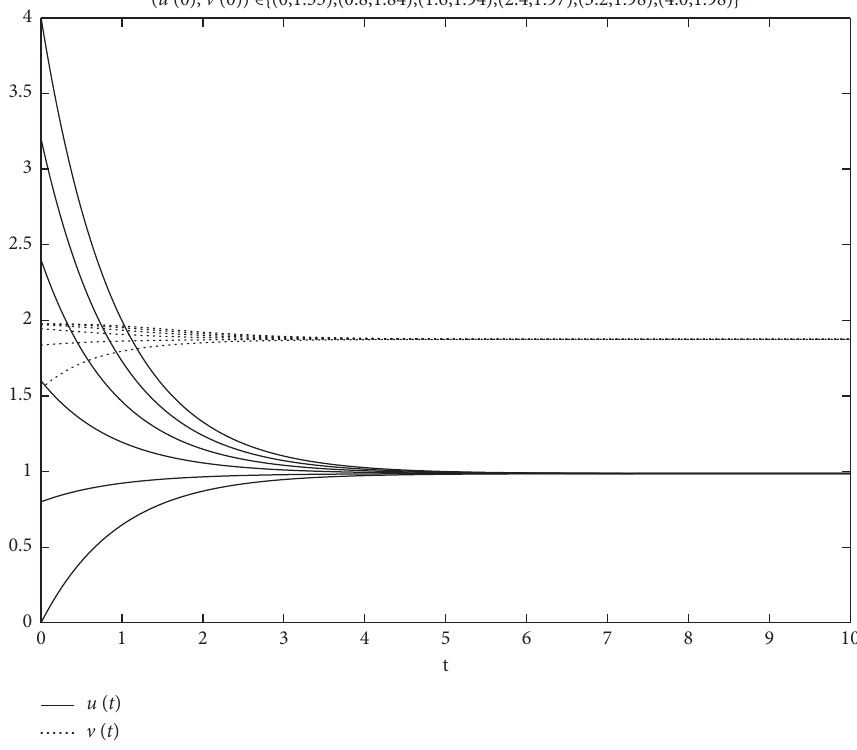
� 0 ,x � 0 . 8 of differential variables. 1 2